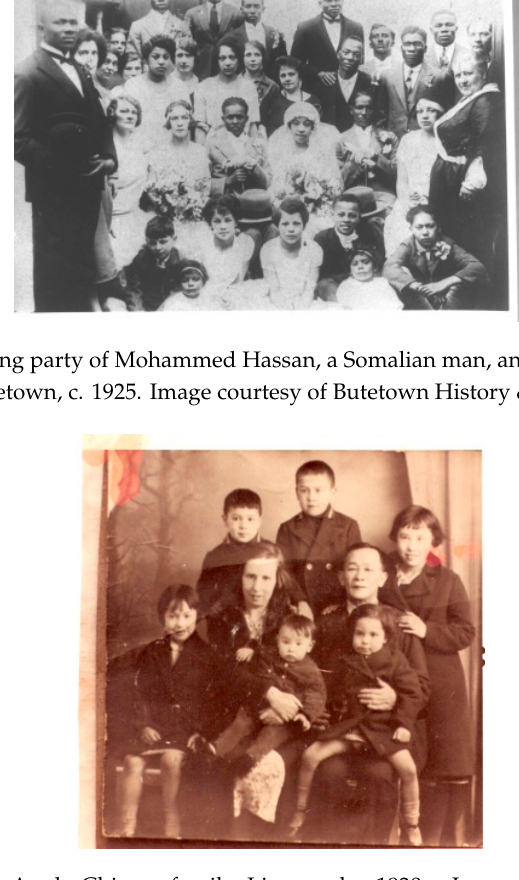
Figure 13. Unknown Anglo-Chinese family, Liverpool, c.1930s. Image courtesy of Yvonne Foley. Foley has campaigned for greater recognition of the brutal repatriation of Chinese seaman by the British government in 1945–1946, many of whom were consequently forced to leave their white wives and children behind. See http://www.halfandhalf.org.uk/.